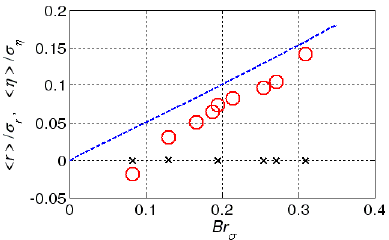
Fig. 9. Mean sea level for different values of Br σ . Circles corre- spond to runup, crosses to the incident wave, and dashed lines to the theoretical Eq. (10).